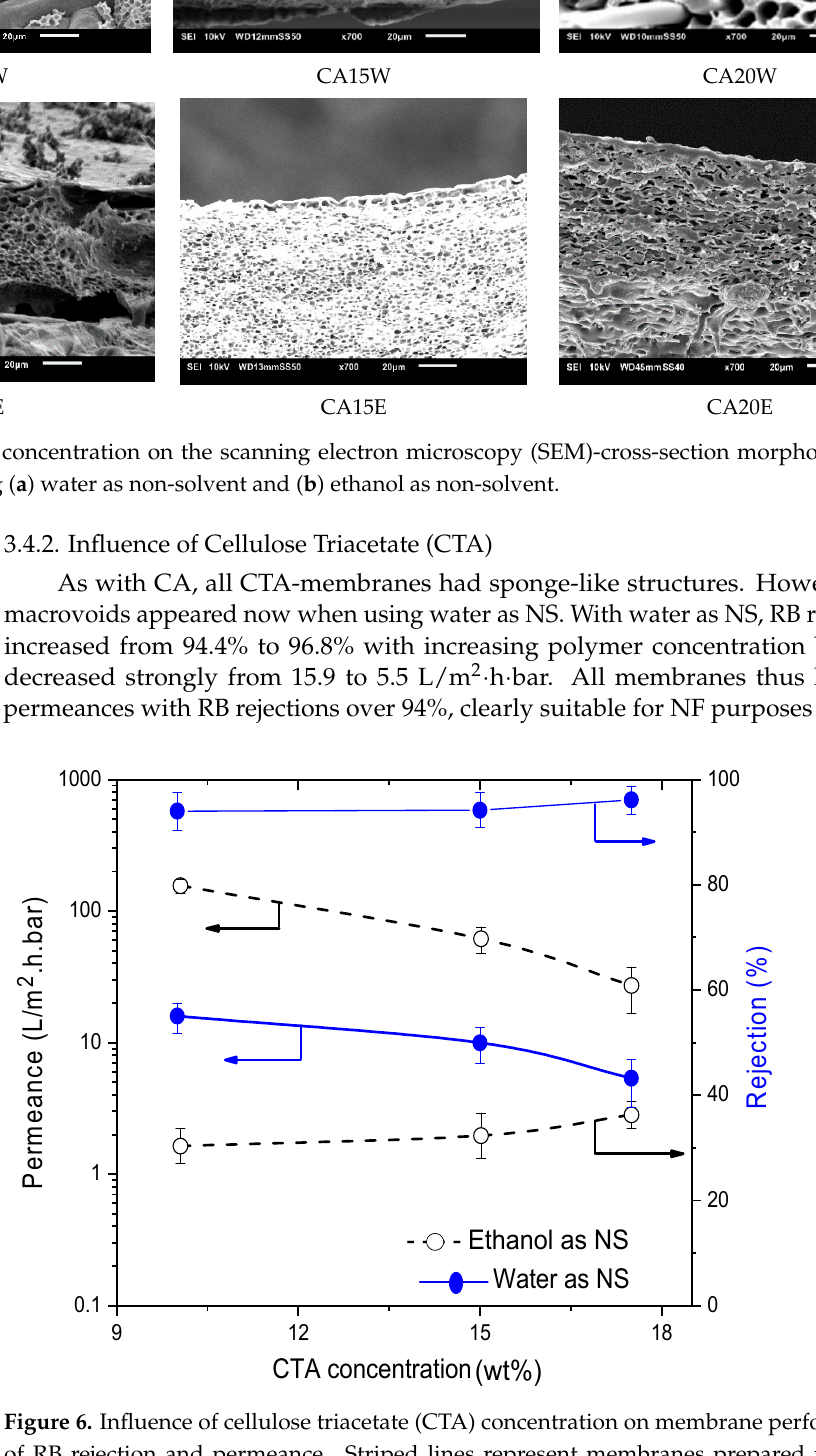
CTA17.5E Figure 7. Influence of CTA concentration on SEM cross-sections of CTA membranes cast from using ( a ) water as non- solvent and ( b ) ethanol as non-solvent.